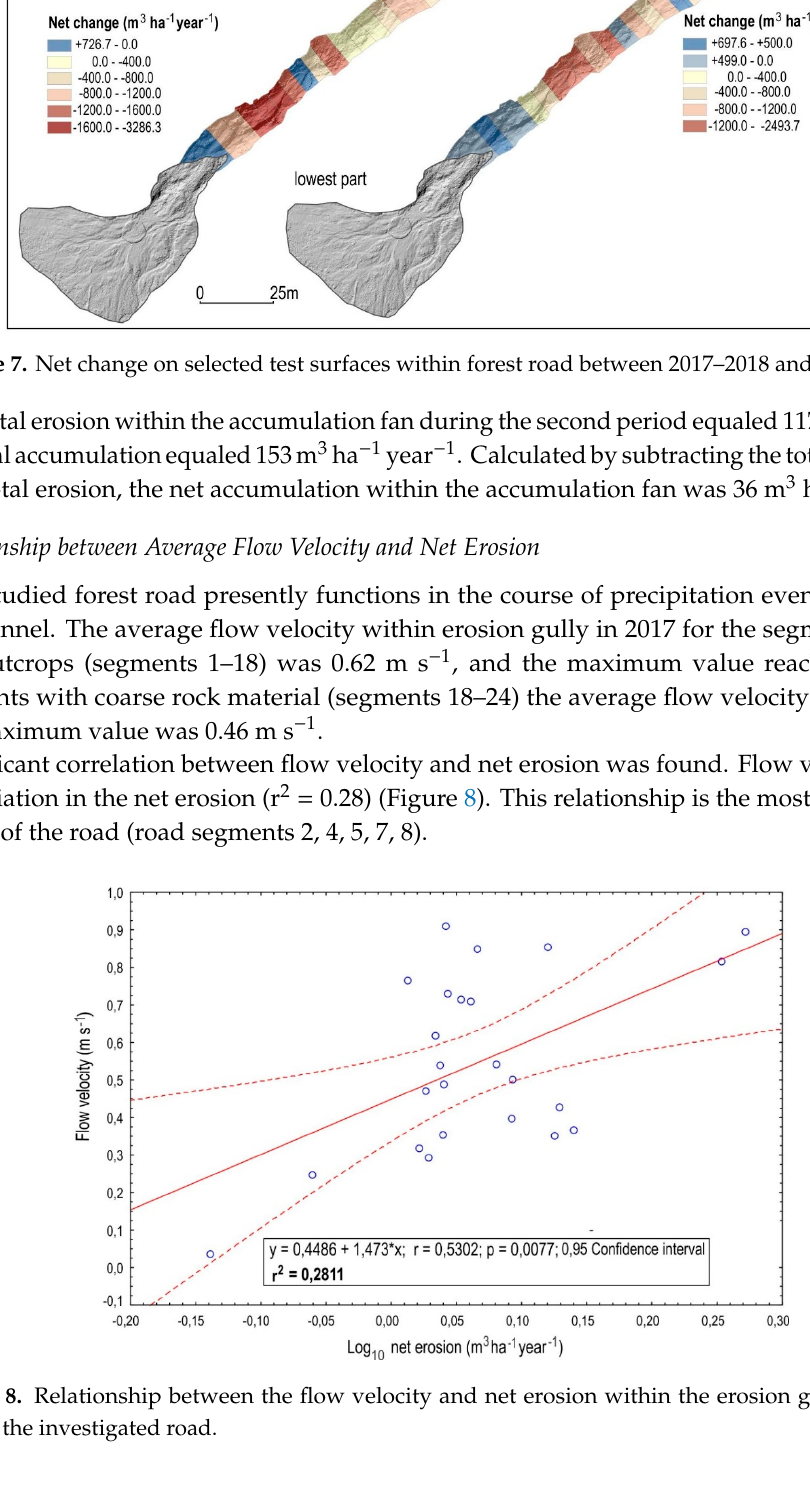
Figure 7. Net change on selected test surfaces within forest road between 2017–2018 and 2018–2019.